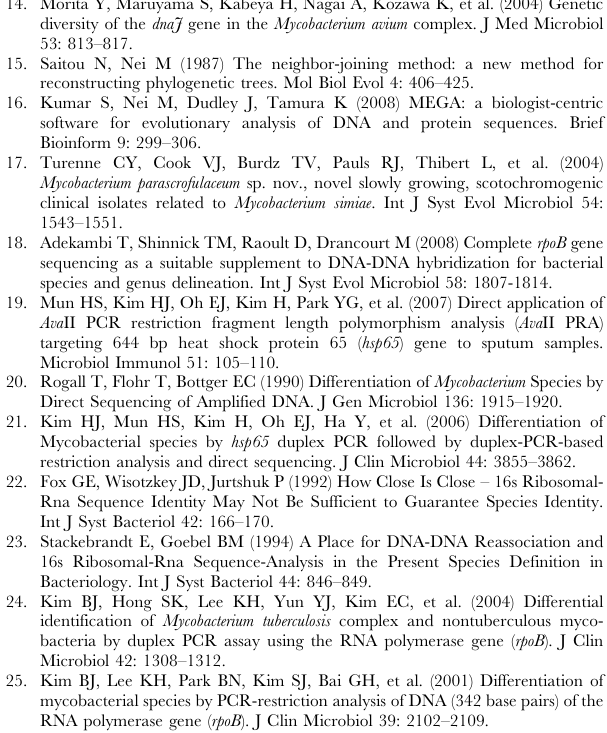
Table S3 Comparison of phenetic and biochemical characteristics between M. yongonense DSM 45126 T , 614 T and M. intracellulare ATCC 13950 T . All strains showed negative results in niacin accumulation test, and positive results in heat stable catalase